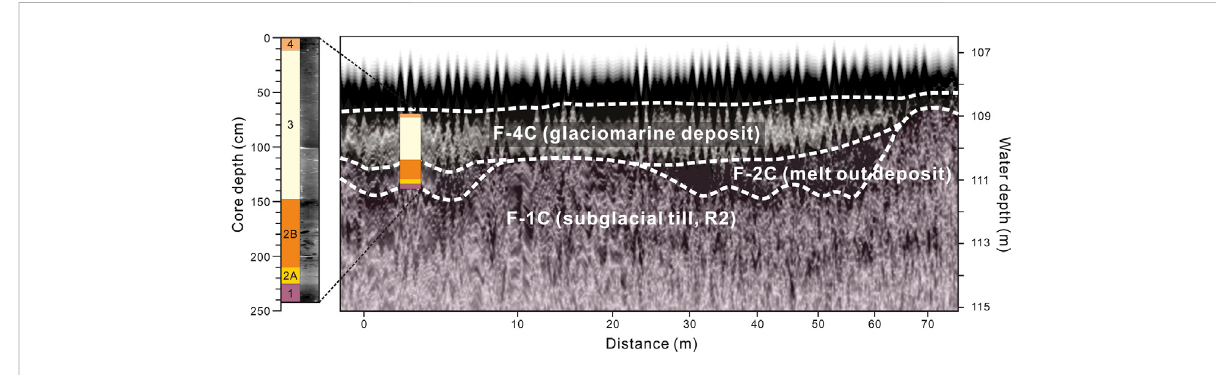
FIGURE 10 Correlation of the acoustic units with lithofacies of core 905 from Little